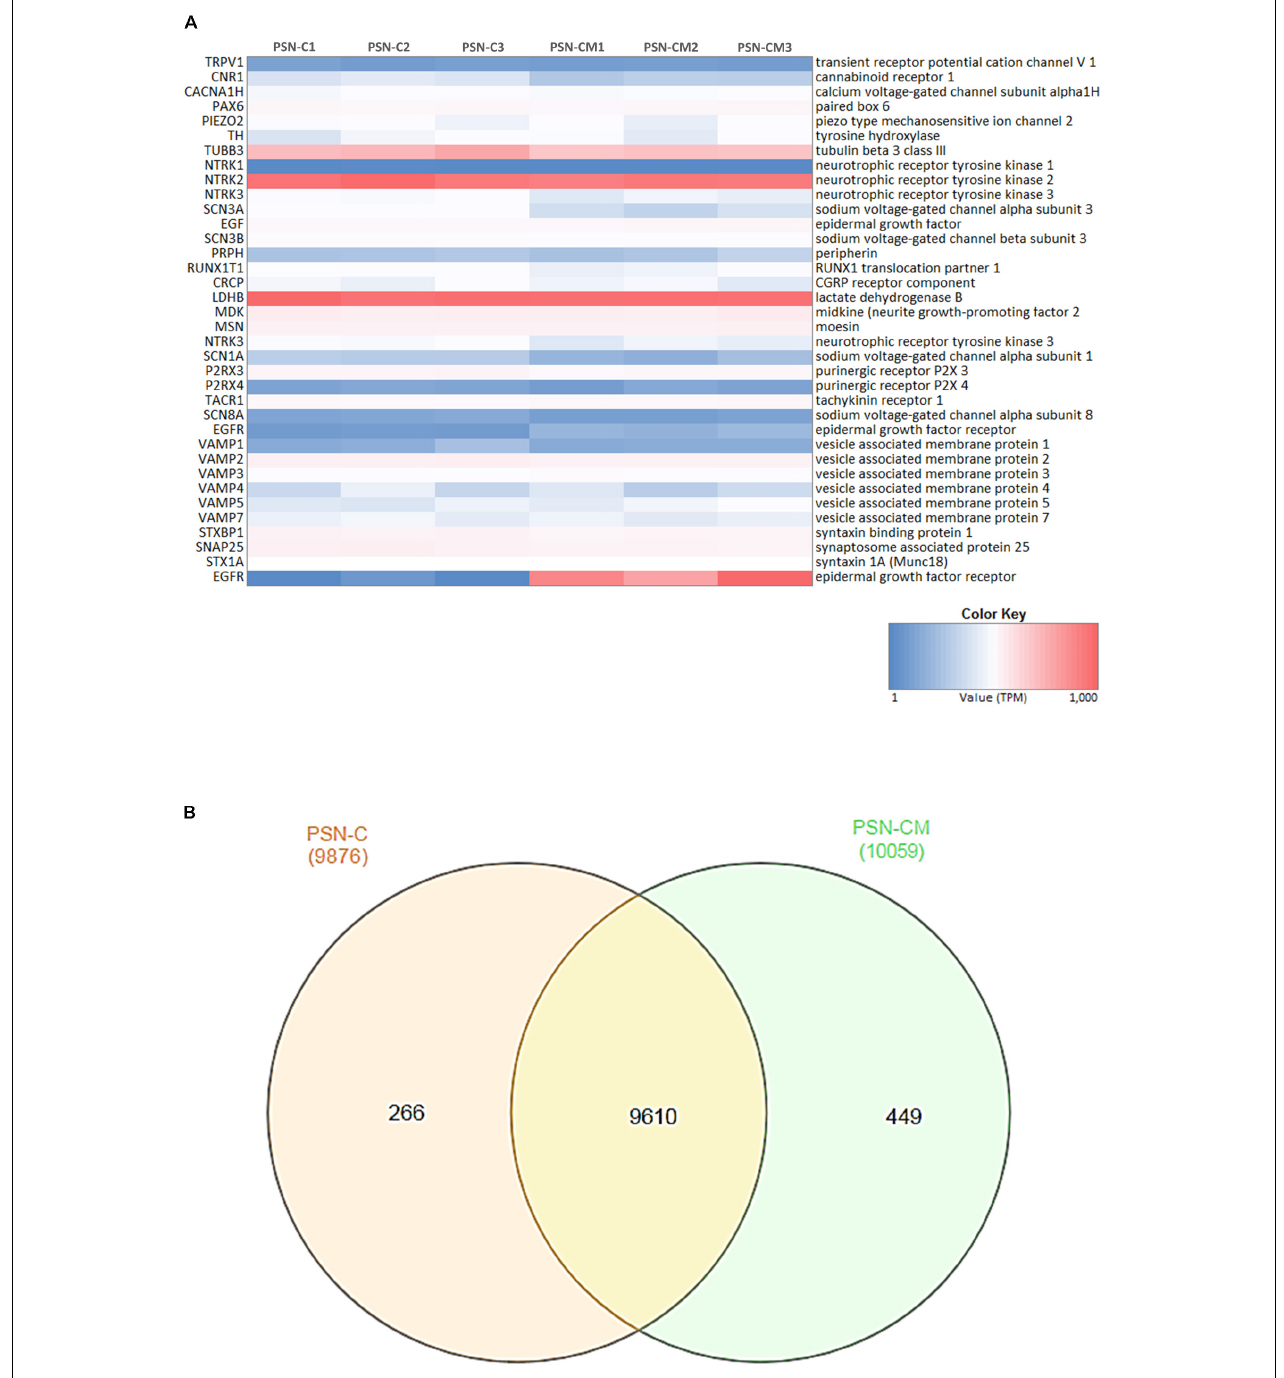
FIGURE 7 | Neuronal markers expressed and regulated in hiPSC-derived PSNs. (A) Heatmap (blue: low expression, red: highly expressed) of transcripts related to neuronal marker genes expressed in cultures of control PSN (PSN-C) and PSN treated with HEK-conditioned media (PSN-CM), obtained from RNA-Seq data. Transcripts coding marker genes Nestin (NES), Peripherin (PRHP), BRN3a (POU4F1). Moreover, mRNA encoding the cannabinoid receptor 1 (CNR1) were found in higher levels compared to TRPV1, which was also expressed but in lower levels. PIEZO2 (piezo type mechanosensitive ion channel component 2), TH (tyrosine hydroxylase), TUBB3 (tubulin beta 3 class III), Neurotrophic receptor tyrosinase 2 (NTRK2, also known as TrkB), SCN3A and SCN3B (Nav 1.3 or sodium voltage-gated channel alpha and beta subunit 3), EGF (epidermal growth factor), RUNX1T1 (RUNX1 translocation partner 1), CRCP (CGRP receptor component), LDHB (lactate dehydrogenase B), MDK (midkine, neurite growth-promoting factor 2), MSN (moesin) and P2RX3, P2RX4 (purinergic receptor P2X ligand-gated ion channel 3 and 4) were highly expressed in all cultures. (B) Venn diagrams were generated using InteractiVenn tool showing unique and shared genes expressed in PSN-C and PSN-CM (treated with